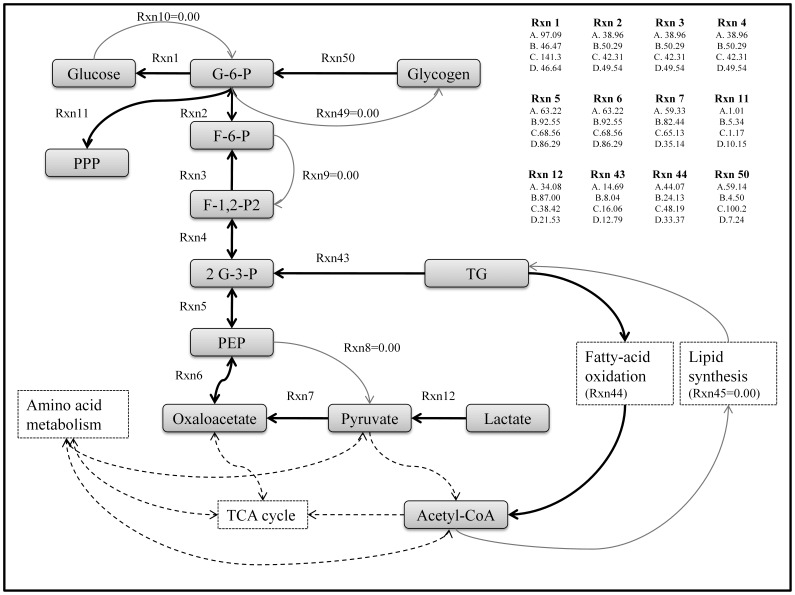
Detailed flux distribution map in the glycolysis, gluconeogenesis and lipid metabolism pathways.Note that several reaction pairs (Rxn 1 vs. Rxn 10; Rxn 3 vs. Rxn 9; Rxn 6 vs. Rxn 8; Rxn 49 vs. Rxn 50; and Rxn 44 vs. Rxn 45) form futile cycles. Thick black lines indicate active (or dominant) reactions whereas gray lines represent inactive (i.e. flux = 0) reactions. Dashed lines depict reactions not shown in detail. Positive flux values for reversible reactions which are in the gluconeogenic pathway in the figure indicate that gluconeogenesis is active. Fluxes of irreversible reactions should be equal or greater than zero. Directions of reactions are given in Table 1. Flux units are µmol/g liver/h. A: Sham+Fed group; B: Sham+Fasted group; C: Burn+Fed group; D: Burn+Fasted group.